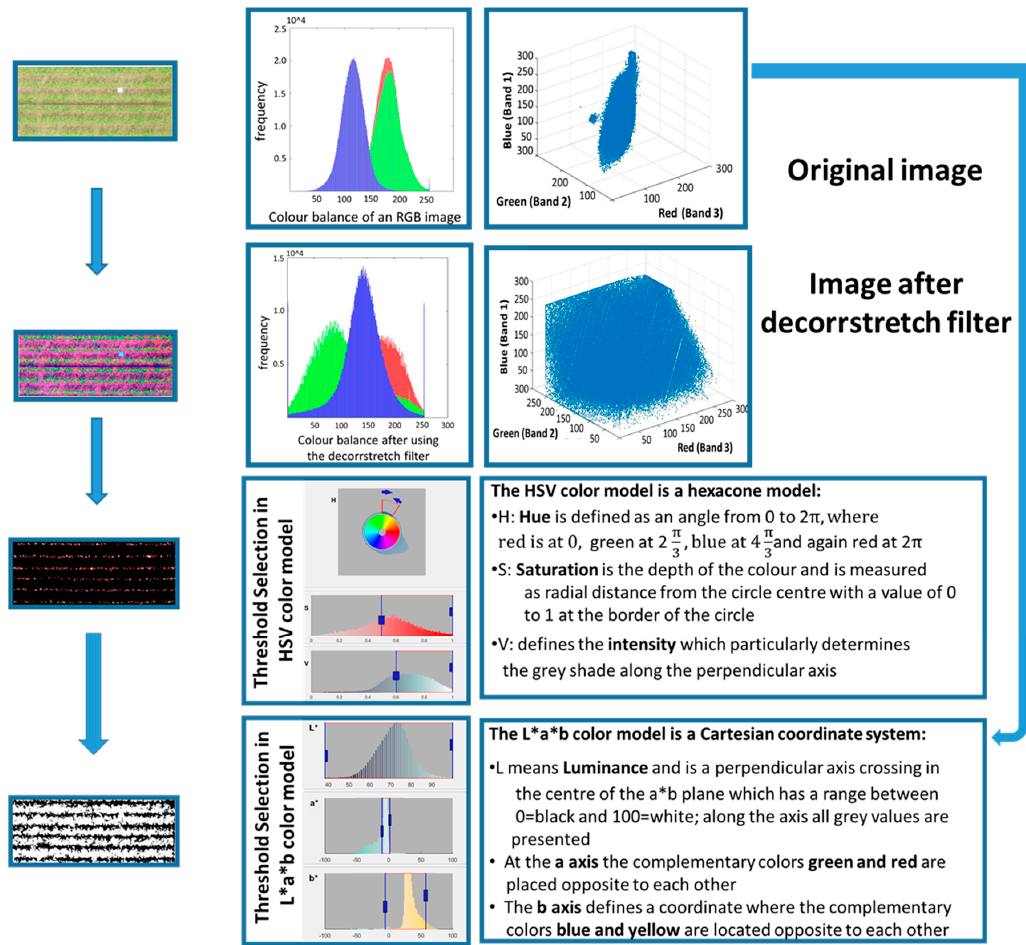
Figure 2. Flowchart of the theoretical image processing steps in MATLAB, where the color scatter plot of the original RGB image is first transformed in a new, wider scatter plot with the decorrstrech contrast enhancement procedure and a pixel segmentation of the light green pixel with a threshold selection in the HSV color model (with the three channels: hue, saturation and value) followed by count the plants at the end. Additionally the L*a*b* color model (where L stays for luminosity, and a and b are vectors to create a color space) was used to select green pixels from the original image to detect ground cover.